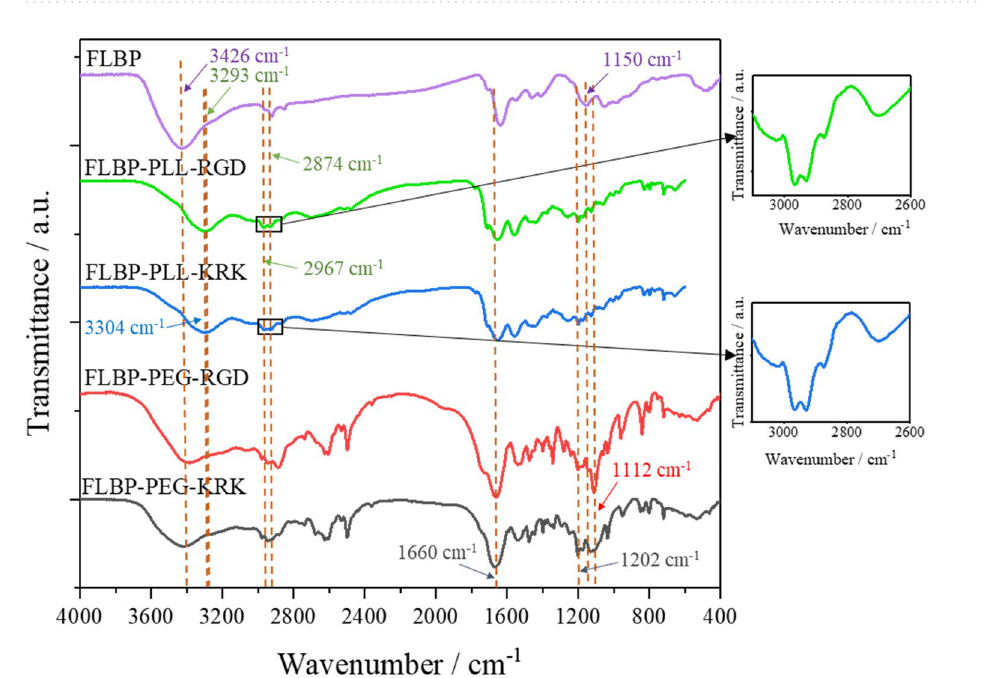
Figure 10. Fourier-transform infrared (FTIR) spectra for few layer black phosphorus (FLBP) and its conjugates: FLBP-PLL-RGD, FLBP-PLL-KRK, FLBP-PEG-RGD and